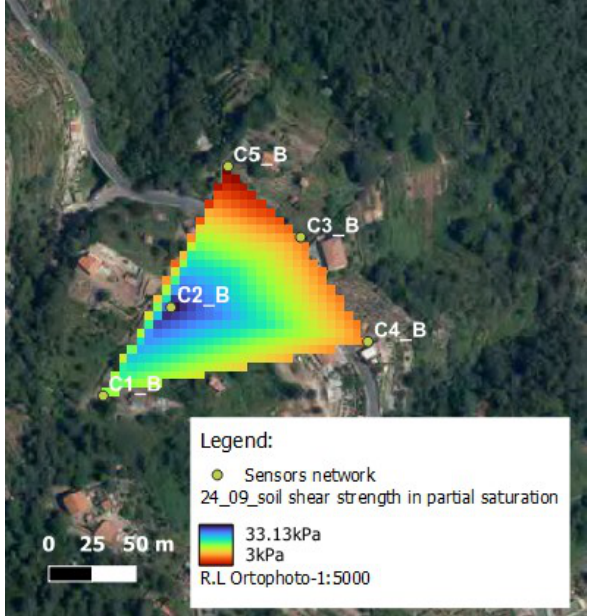
Figure 7. The shear strength surface induced by partial saturation referring to 24/09/2020, after the first significant rainfall occurred on 22/09/2020.